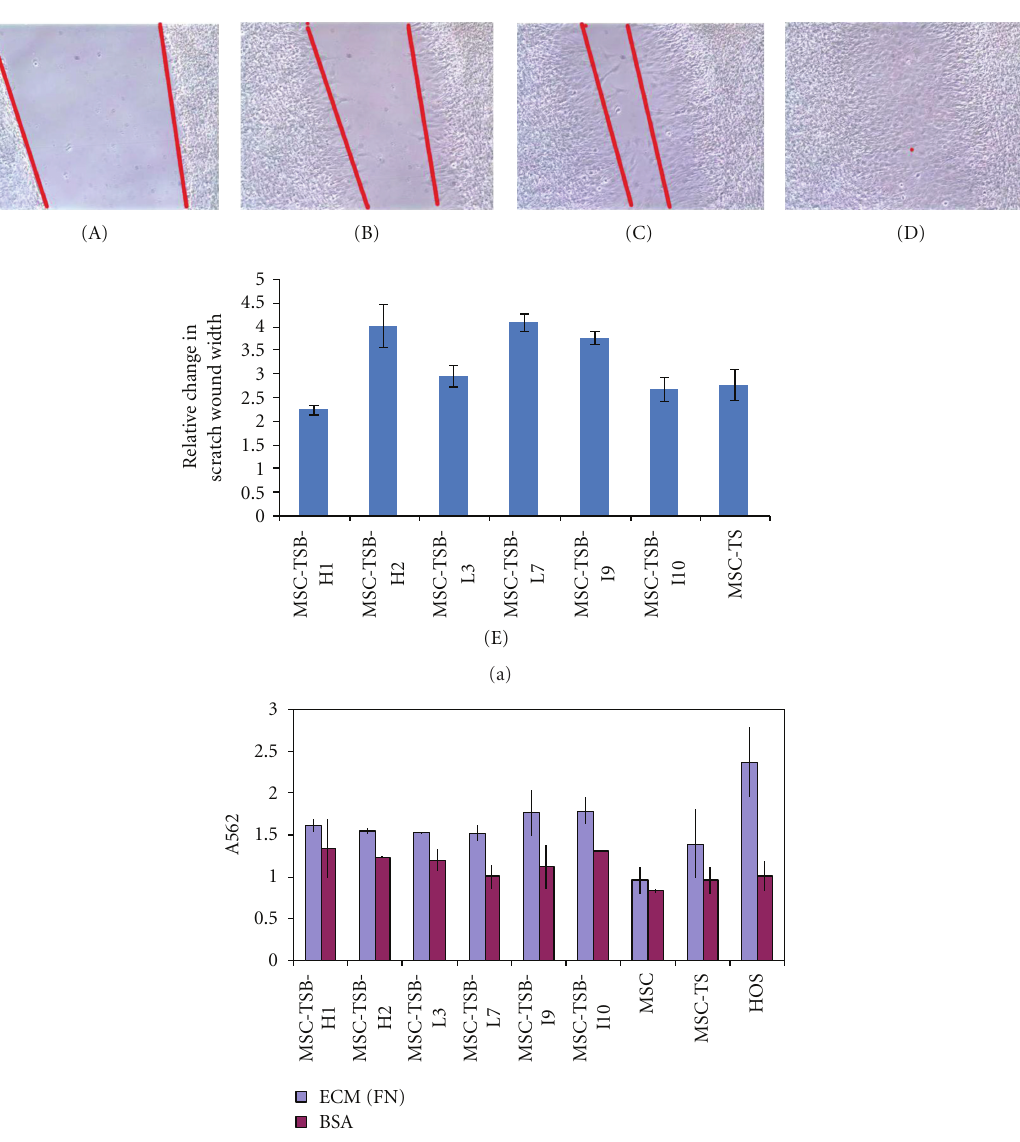
Figure 3: Migration assay. (a) A single representative wound healing assay (10x magnification), which showed no significant di ff erences, P > 0 . 05, between the variants and the parental cell line MSC-TS at (A) 0 hour, (B) 12 hours, (C) 24 hours, and (D) 48 hours. (E) Quantitative measurement of wound gap by Image J software also showed no statistical significance between clones and the parental line. (b) A summary of the Boyden chamber experiment results; BSA coated wells serve as control along with HOS cells. Bars, standard deviation (SD). Experiments were replicated three